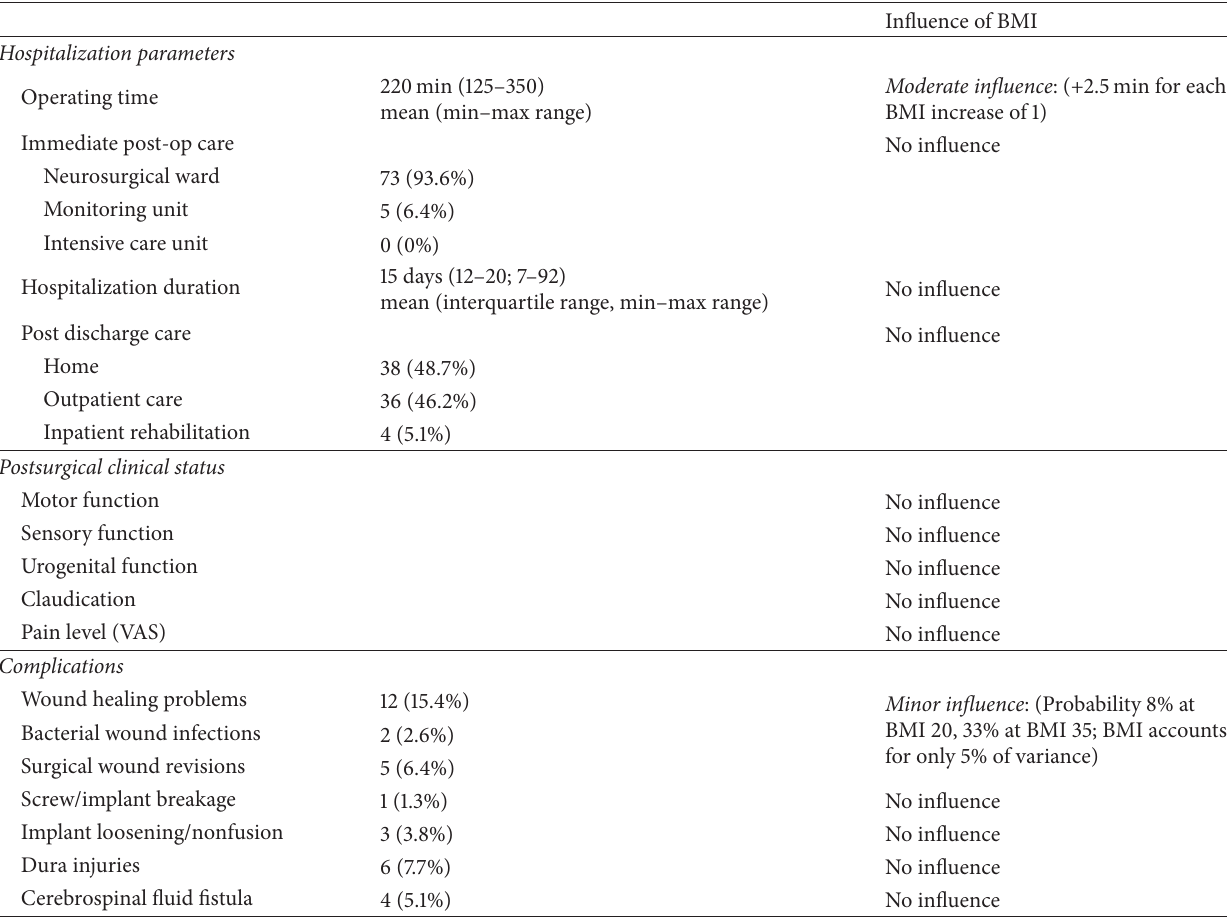
Table 2: Summary of influence of BMI on hospitalization parameters, clinical status, and adverse events. Multinomial regression was used to analyze the influence of BMI (body mass index) on post-op care, Cox proportional hazard regression was used for hospitalization duration, and multinomial regression was used to analyze the influence of BMI on postdischarge care. The influence of BMI on motor and sensory function was analyzed with multiple regression first, as well as logistic regression comparing postsurgical improvement scores. Logistic regression was used to assess the influence of BMI on change in urogenital dysfunction and spinal claudication as well as on the appearance of adverse events. Ordinal regression was used to analyze the influence of BMI on change in pain